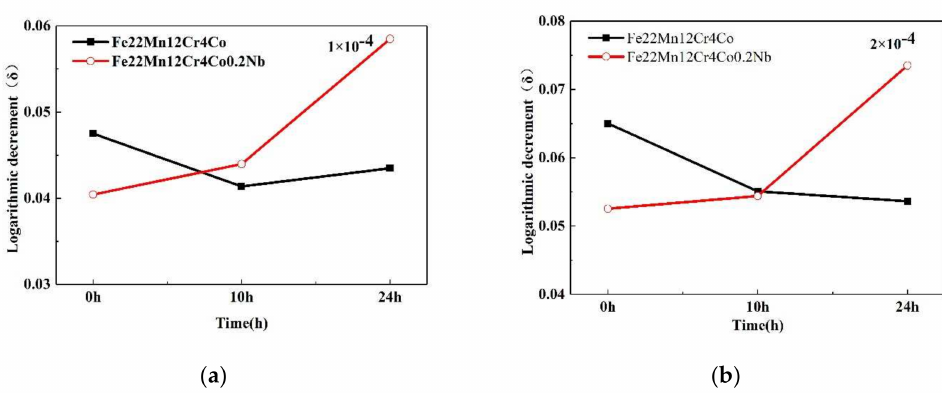
Figure 3. Effect of aging time on two alloy specimens at different strain amplitudes of damping performance. ( a ) 1 × 10 − 4 strain amplitude; ( b ) 2 × 10 − 4 strain amplitude. The backscattered electron images of Fe-22Mn-12Cr-4Co-0.2Nb-0.02C annealed at 1100 ◦ C show hundreds of nanometers of second-phase NbC (white spots with arrows) in the alloy matrix, as shown in Figure 4.